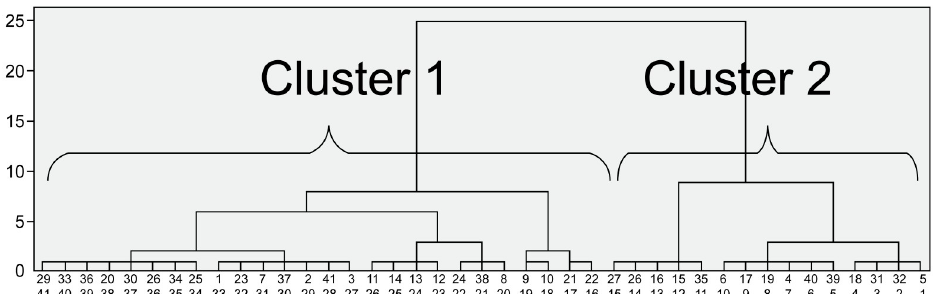
Fig 2. Dendrogram representing the minimum variance hierarchical classification of the Functional Reach Test patterns in young participants (Ward method; Euclidian distances).